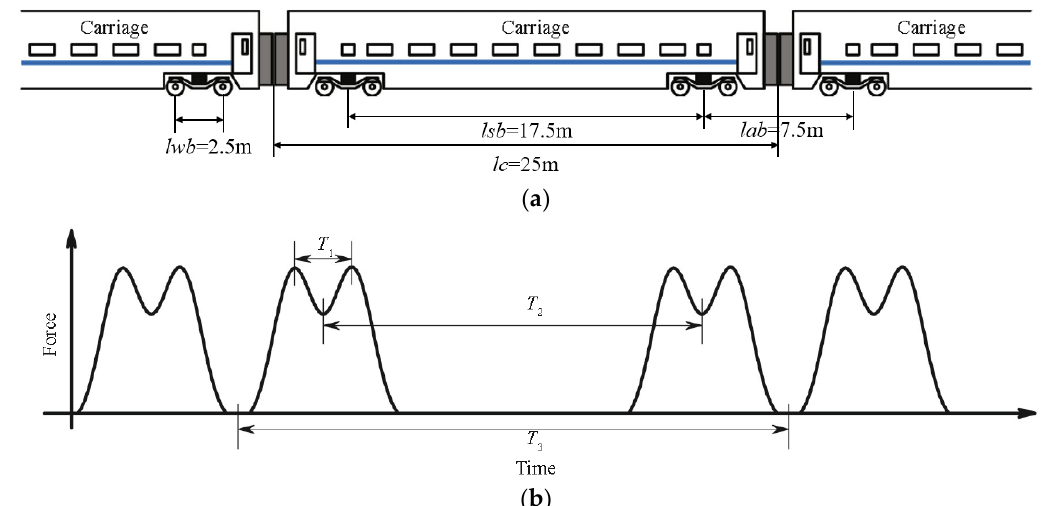
Figure 4. Geometry configuration of the high-speed trains and M-shaped wave. ( a ) Geometry configuration of the high-speed trains, ( b ) M-shaped wave.